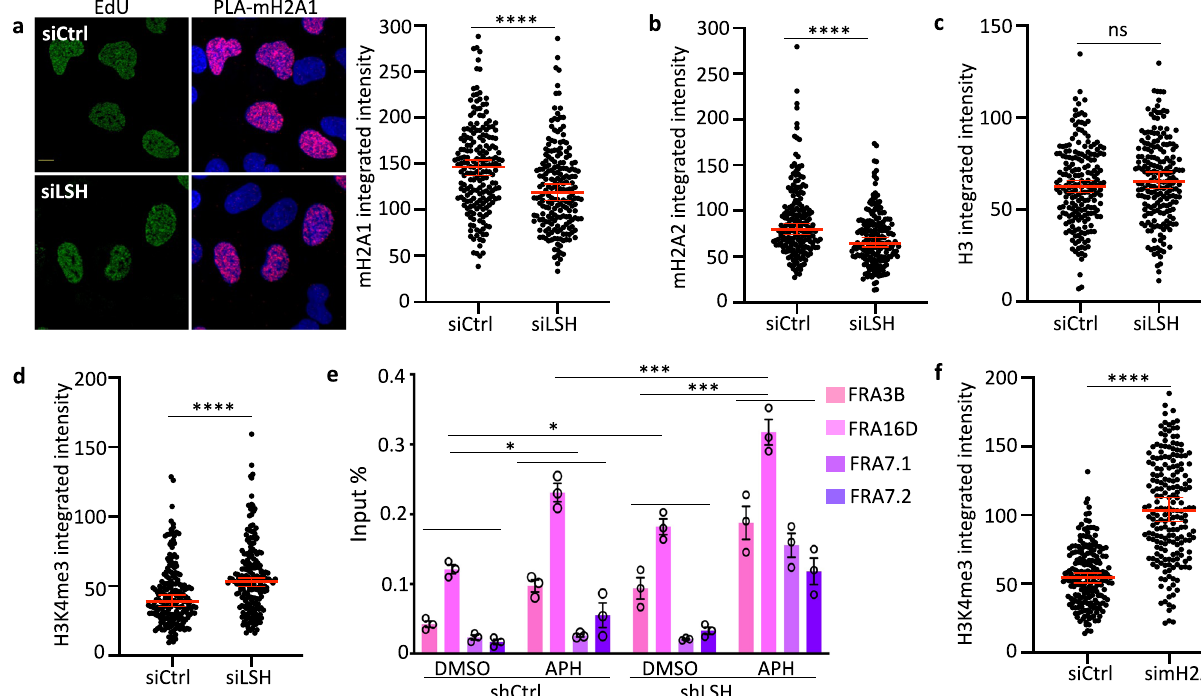
Fig. 7 Abnormal chromatin environment at stalled forks in LSH-de fi cient cells. a Representative images (left panel) and quanti fi cation of PLA signals (mH2A1: EdU, right panel) from U2OS cells transfected with the indicated siRNA after exposure to 4 mM HU for 5 h. The scale bar represents 10 µ m. Quanti fi cation of PLA signals (mH2A1: EdU) is based on EdU-positive cells. Representative of n = 3 independent experiments. Data are represented as median± 95% CI ( n = 200 cells). **** p < 0.0001 by two-tailed Mann – Whitney test. b Quanti fi cation of PLA signals (mH2A2: EdU) from U2OS cells transfected with the indicated siRNA after exposure to 4 mM HU for 5 h. Quanti fi cation of PLA signals (mH2A2: EdU) is based on EdU-positive cells. Representative of n = 3 independent experiments. Data are represented as median ± 95% CI ( n = 200 cells). **** p < 0.0001 by two-tailed Mann – Whitney test. c Quanti fi cation of PLA signals (H3: EdU) from U2OS cells transfected with the indicated siRNA (siCtrl or siLSH) after exposure to 4 mM HU for 5 h. Quanti fi cation of PLA signals (H3: EdU) is based on EdU-positive cells. Representative of n = 3 independent experiments. Data are represented as median ± 95% CI ( n = 200 cells). ns = not signi fi cant by two-tailed Mann – Whitney test. d Quanti fi cation of PLA signals (H3K4me3: EdU) from U2OS cells transfected with the indicated siRNA (siCtrl or siLSH) after exposure to 4 mM HU for 5 h. Quanti fi cation of PLA signals (H3K4me3: EdU) is based on EdU- positive cells. Representative of n = 3 independent experiments. Data are represented as median± 95% CI ( n = 200 cells). **** p < 0.0001 by two-tailed Mann – Whitney test. e ChIP-qPCR analysis for detection of H3K4me3 enrichment at CFSs in mock-treated (DMSO) or aphidicolin-treated (APH) U2OS cells transfected with shLSH or shCtrl. Data are represented as mean ± SD ( n = 3 independent experiments). * p < 0.05, *** p < 0.001 by Student ’ s two-tailed t test. f Quanti fi cation of PLA signals (H3K4me3: EdU) from U2OS cells transfected with the indicated siRNA (siCtrl or simH2A) after exposure to 4 mM HU for 5 h. Quanti fi cation of PLA signals (H3K4me3: EdU) is based on EdU-positive cells. Representative of n = 3 independent experiments. Data are represented as median± 95% CI ( n = 200 cells). **** p < 0.0001 by two-tailed Mann – Whitney